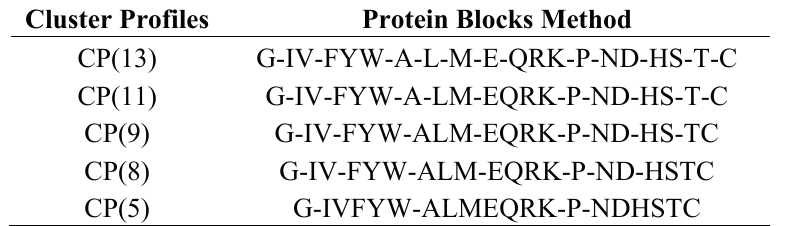
Table 1. Scheme for reduced amino acid alphabet based on protein blocks method.